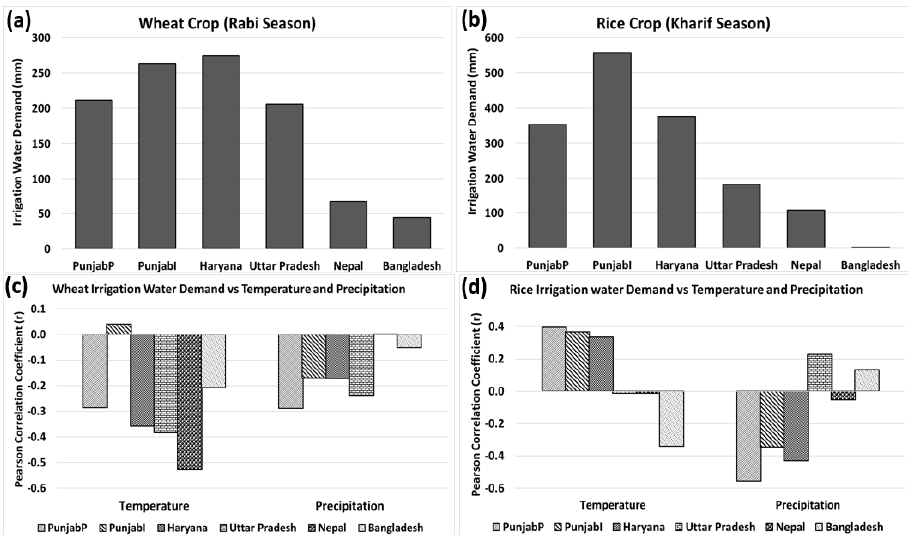
Figure 3. Crop−specific seasonal irrigation water demand (mm) by wheat ( a ) and rice ( b ) crops and their relationship with temperature and precipitation ( c , d ) estimated over six study sites in the IGB river basins during period 1981–2010.